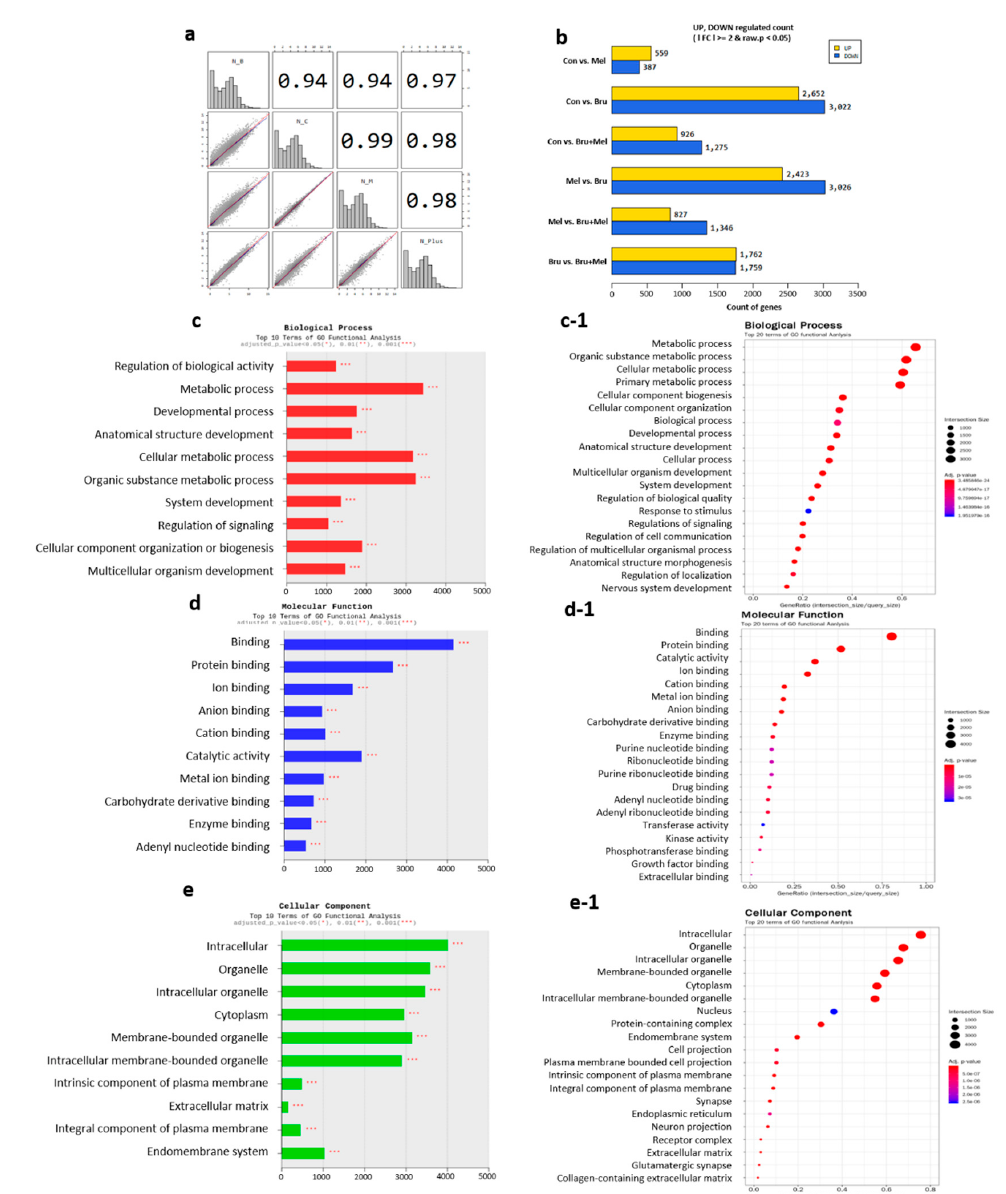
Figure 5. Evaluation of sample reproducibility and results of the top 10 terms of GO